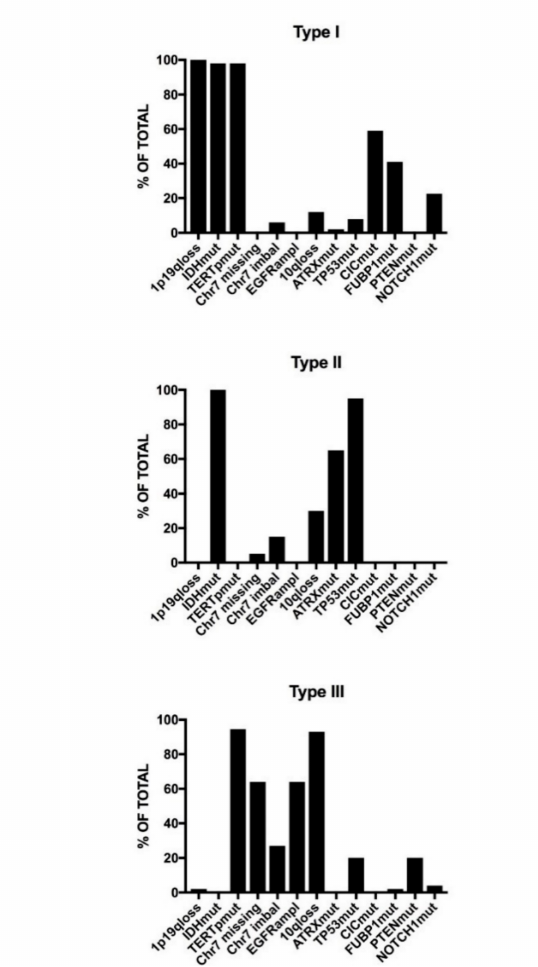
Figure 5. Somatic genetic abnormalities observed in adult anaplastic oligodendrogliomas. These tumors are subdivided into three subgroups (Type I, II, and III) according to molecular criteria. % of total indicates the percentage of patients of each tumor type with a given genetic abnormality. Data are reported in Dubbink et al., 2016